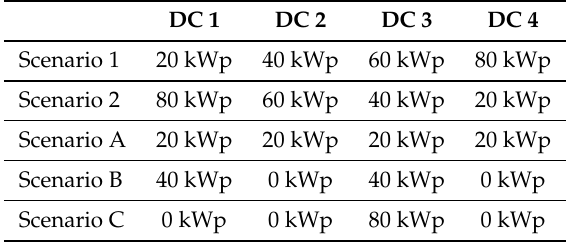
Table 2. Scenarios for the distribution of PV panels.